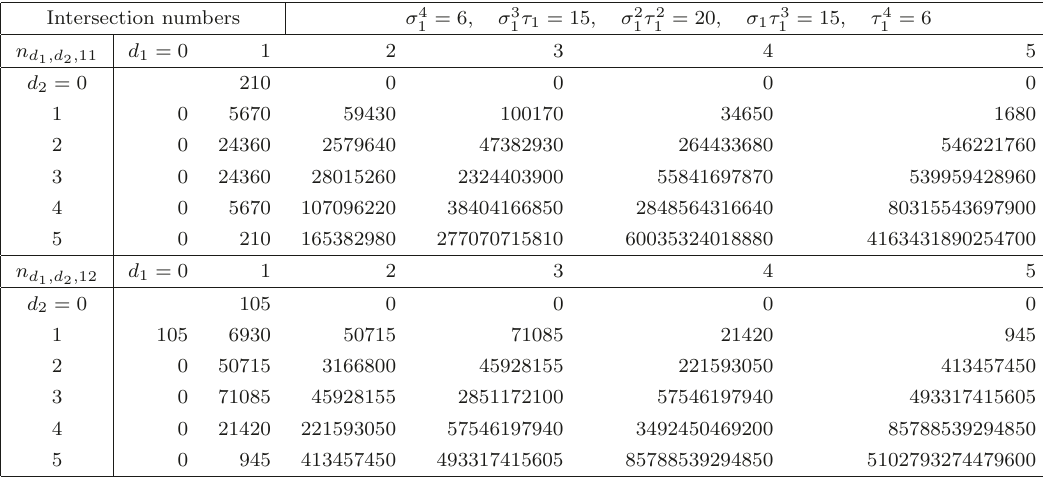
Table 7 . Genus-0 invariants of determinantal 4-folds in (A.6) with V = P 5